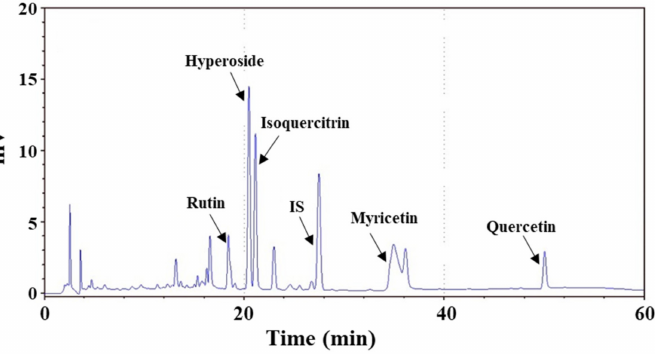
Figure 6. HPLC chromatograms of AME: Identified components—rutin, hyperoside, isoquercitrin, myricetin, and quercetin. The peak of the internal standard (naringin) is denoted as